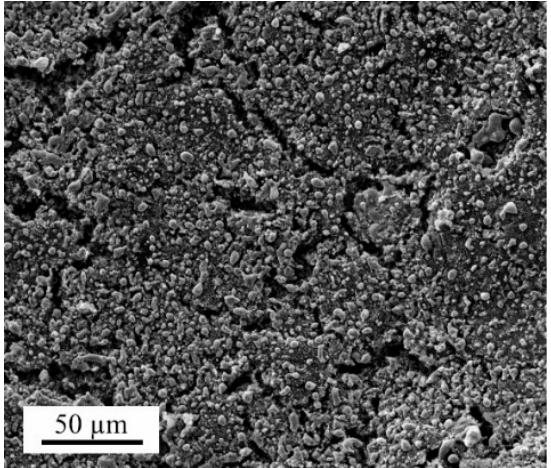
Figure 1. SEM image of the surface of a sample with Ni annealed at 1100 °C. EDS showed the following values for the averaged composition of particles coming to the surface: 32 at.% Ni; 18.8 at.% Si; 44.9 at.% C; 0.6 at.% F; 3.5 at.% O. We registered a signif- icant excess of the nickel content in the surface layer of the sintered composite in relation to other elements as compared with the calculated values. This observation can be explained by the fact that the nickel nitrate was initially concentrated in their near-surface layer, as a result of drying the pellets soaked in a salt solution. This spatial distribution of salt is